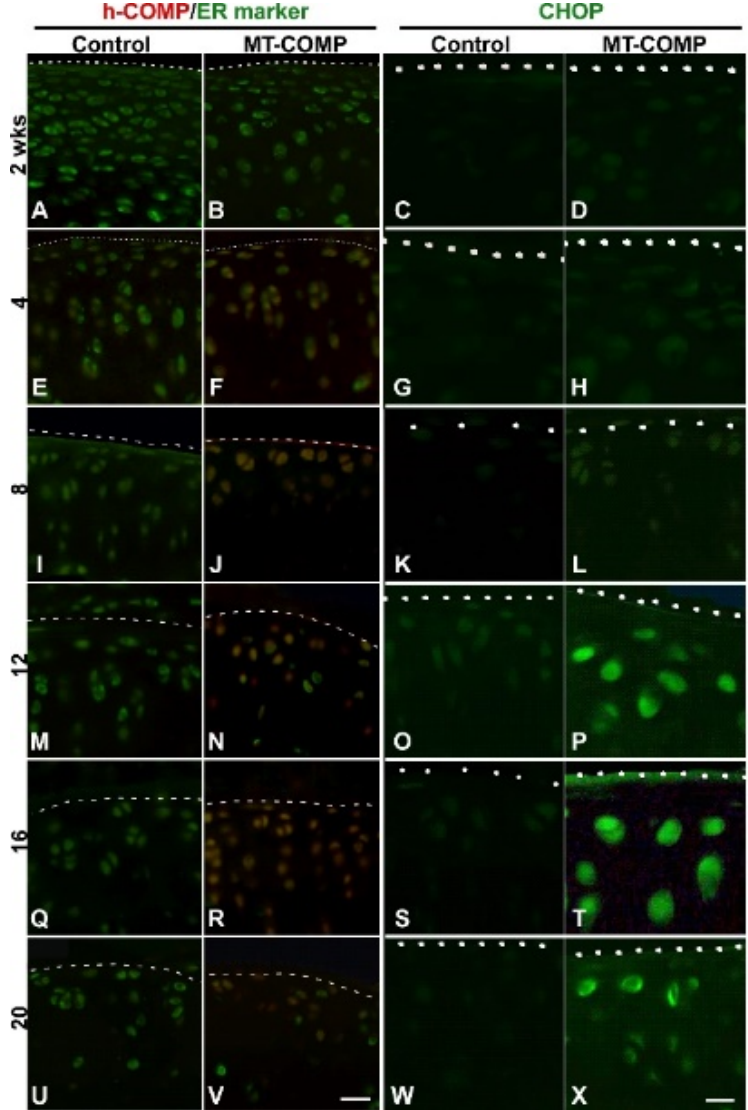
Figure 1. Retention of human mutant-COMP in ER of MT-COMP articular chondrocytes at 4 weeks, with CHOP expression at 12 weeks. All mice were administered DOX from birth to collection at 2, 4, 8, 12, 16, and 20 weeks. Dotted line marks the edge of articular cartilage. Control and MT-COMP tibial articular cartilages were immunostained using human COMP-specific antibodies (red) and protein disulfide isomerase (PDI) (green), an ER marker ( A , B , E , F , I , J , M , N , Q , R , U , V ). Mutant-COMP was expressed and retained in the ER of articular chondrocytes of MT-COMP at 4 weeks ( F , J , N , R , V ) but not in the controls ( A , E , I , M , Q , U ). CHOP immunostaining is shown in C , D , G , H , K , L , O , P , S , T , W , X . CHOP was present in MT-COMP articular chondrocytes at 12, 16, and 20 weeks ( P , T , X ) and absent in the controls ( C , G , K , O , S , W ). ( A , B , E , F , I , J , M , N , Q , R , U , V ) Bar = 100 µ m; ( C , D , G , H , K , L , O , P , S , T , W , X ) Bar = 50 µ